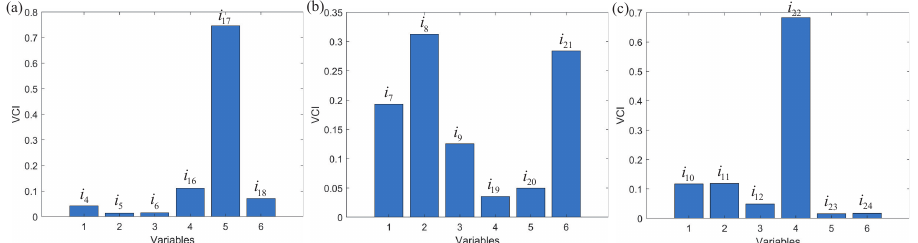
Figure A3. The variable isolation results in anode slippage of aluminum electrolysis industrial process. ( a ) Block 2; ( b ) Block 3; ( c ) Block